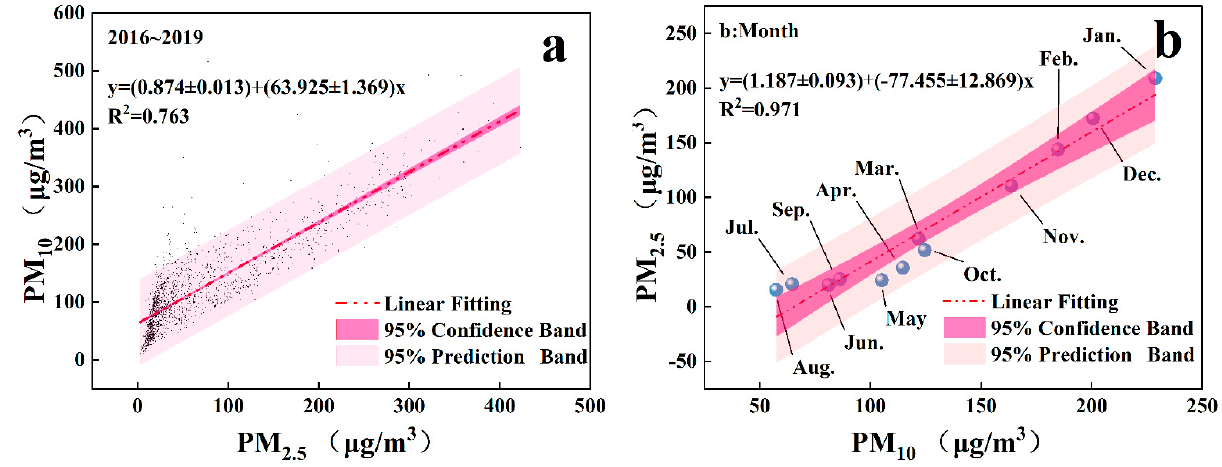
Table 5. Spearman’s correlation coefficients between PM 2.5 and five other pollutants in different seasons.